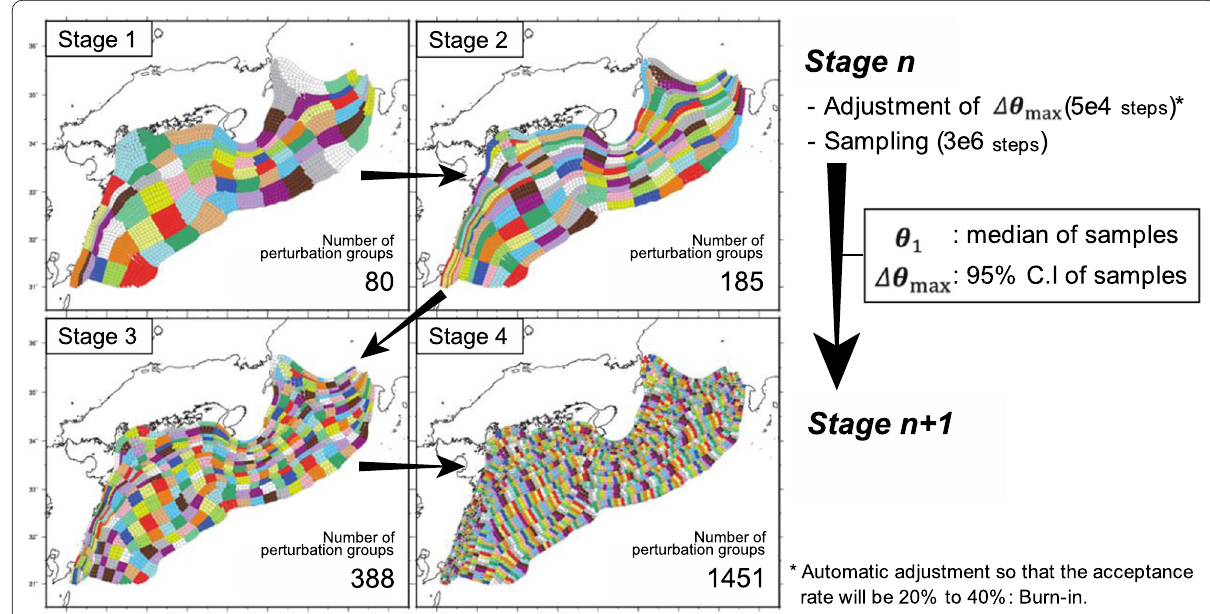
Fig. 2 “Stepwise partitioning algorithm” overview, depicting transition from stage n to stage n + 1 ( n = 1,2,3 ). Colors indicate the perturbation groups of (cid:31) θ . Perturbation groups that differ from stage to stage enable search from the outline to the details without smoothing constraints. The number of perturbations (cid:31) θ max that differ for each perturbation group enables a flexible parameter search with large estimation